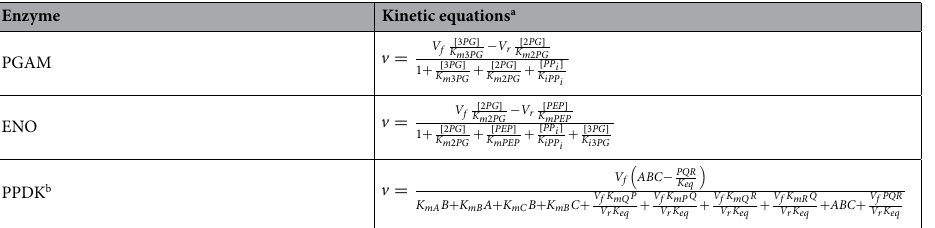
Table 2. Kinetic equations of the enzymes in the second part of the glycolysis. a In models using k cat and E, V f were replaced by k cat _ f · E and V r were replaced by k cat _ r · E . b A, B and C and K mA , K mB and K mC are respectively the concentrations and K m of the substrates PEP, AMP and PP i ; P, Q and R and K mP , K mQ and K mR are the concentrations and K m of the products Pyr, ATP, P i .